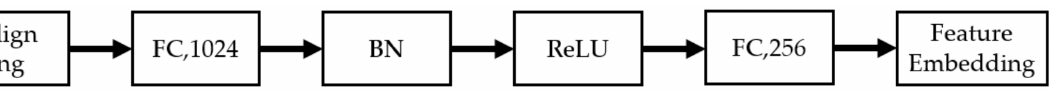
Figure 5. Structure of DML encoding